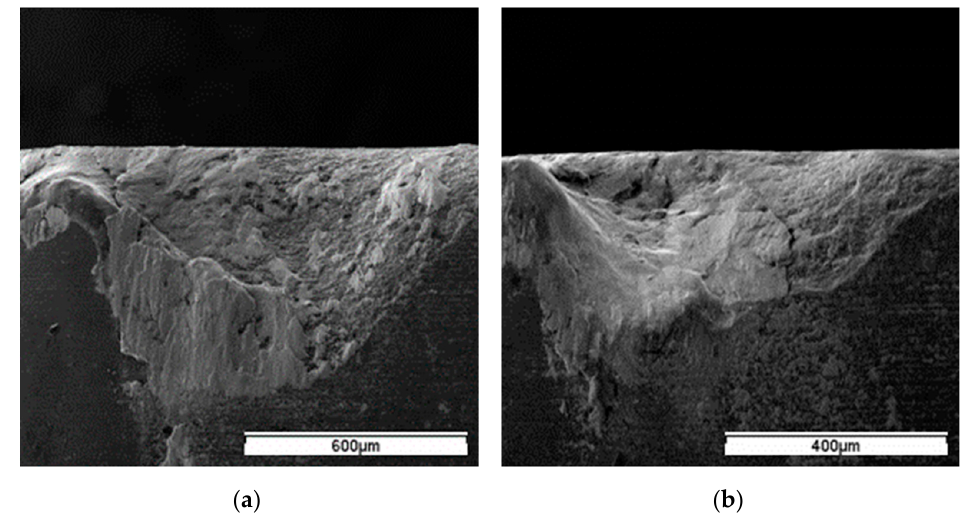
Figure 9. Typical notching of: ( a ) WG300 at 250 m/min; ( b ) SX9 at 200 m/min.